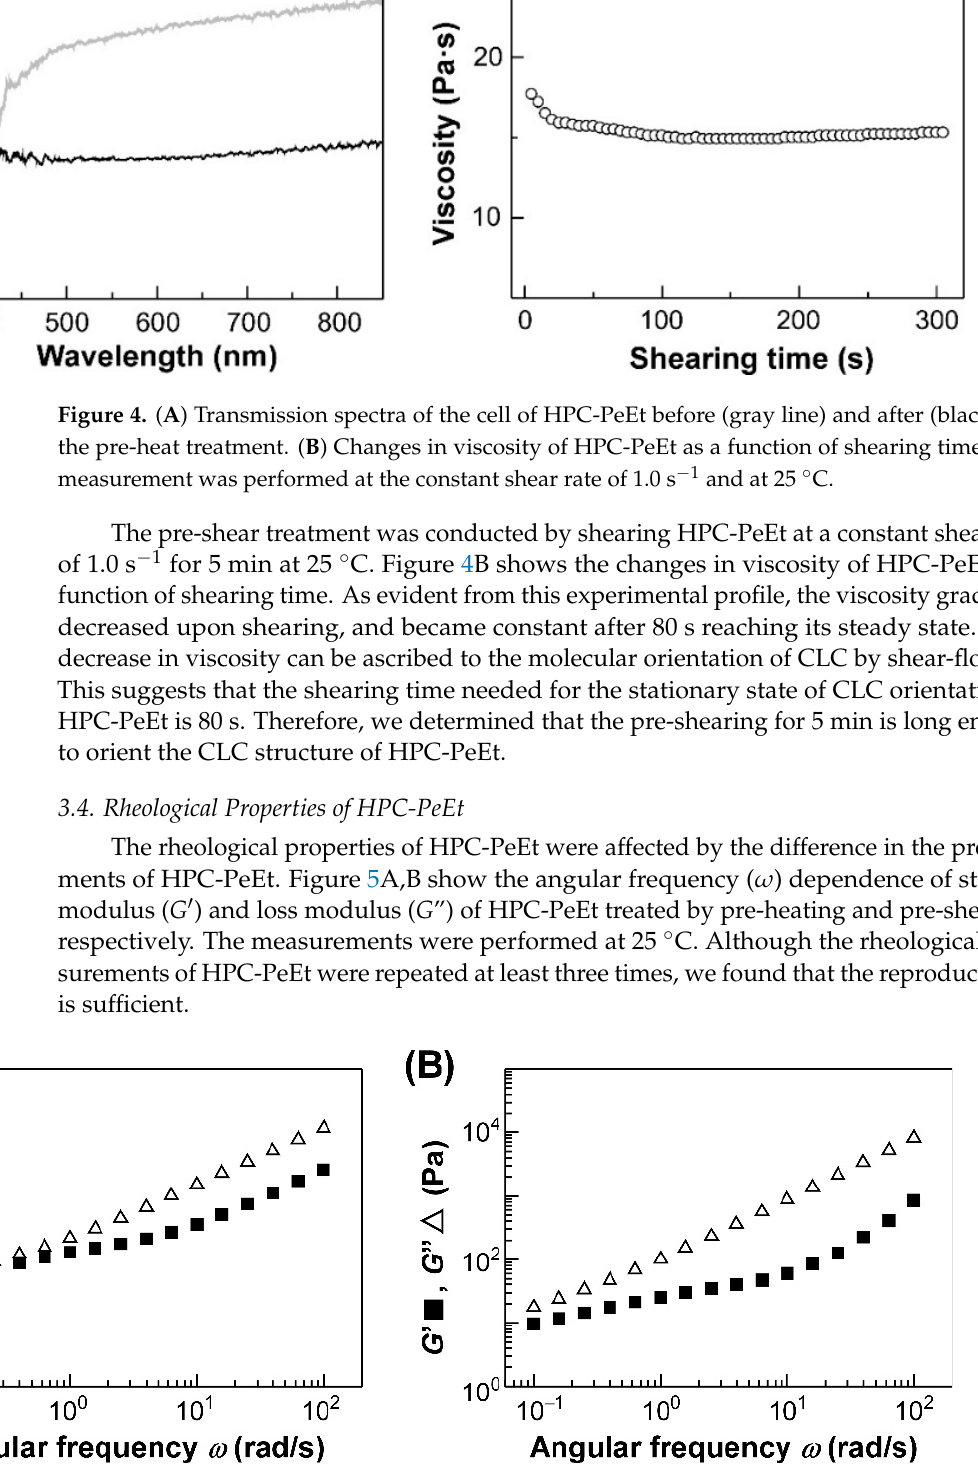
Figure 5. Angular frequency dependence of the storage modulus ( G ′ ; closed squares) and loss modulus ( G ″ ; open triangles) values of HPC-PeEt measured at 25 °C. Before the rheological measurements, HPC-PeEt was either pre-heated ( A ) or pre-sheared ( B ).